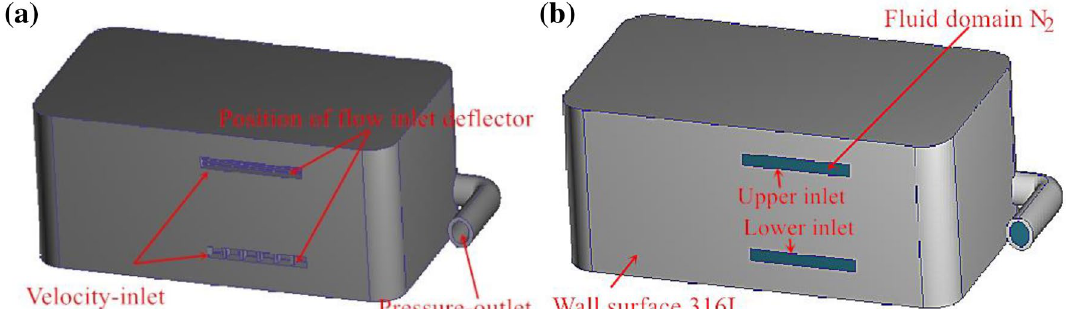
Figure 4. Schematic diagram of 3D printer forming cavity structure and simulation model: ( a ) Forming cavity structure; ( b ) Fluid simulation